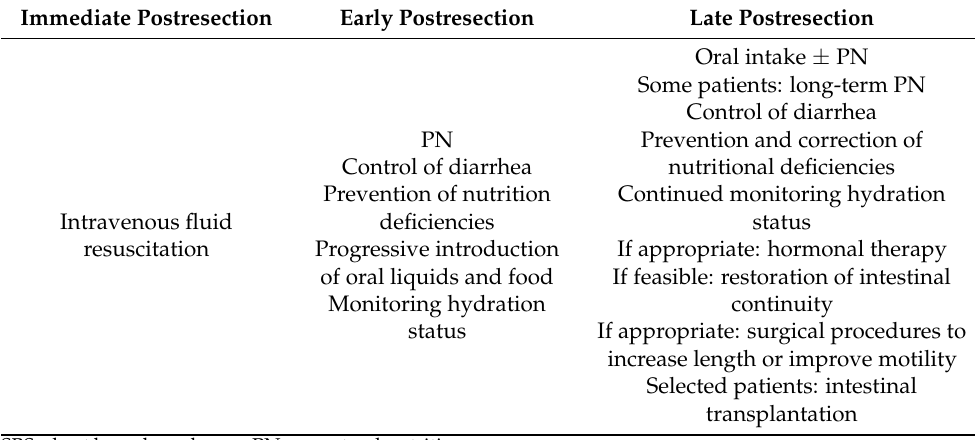
Table 7. Management of